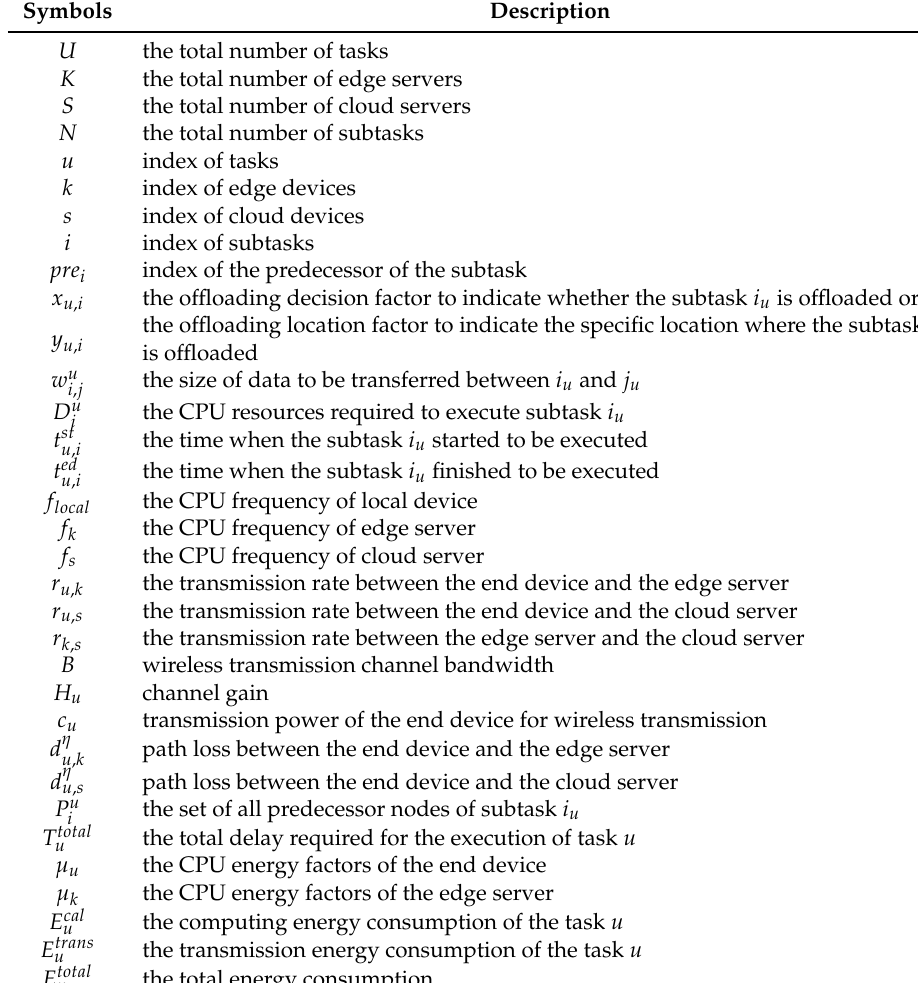
Table 1. Important symbols used in the paper and their